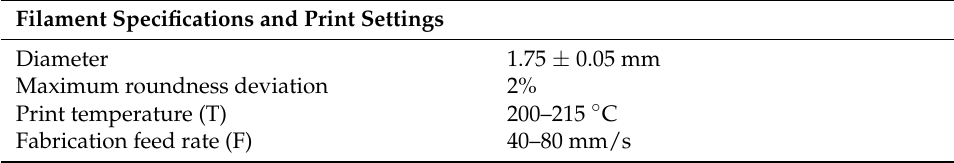
Table 1. PLA filament